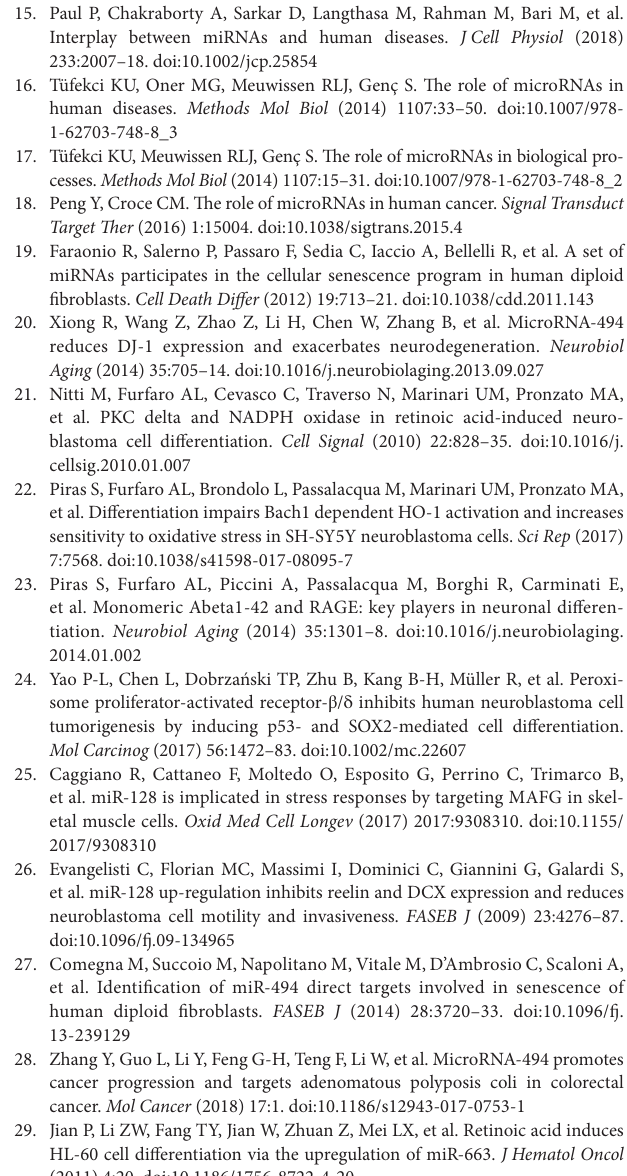
was set equal to 1. Statistical analysis: n = 3; *p < 0.05 vs undifferentiated. (B) WB analysis of BAX in SH-SY5Y cells treated with miR-494 inhibitor and exposed